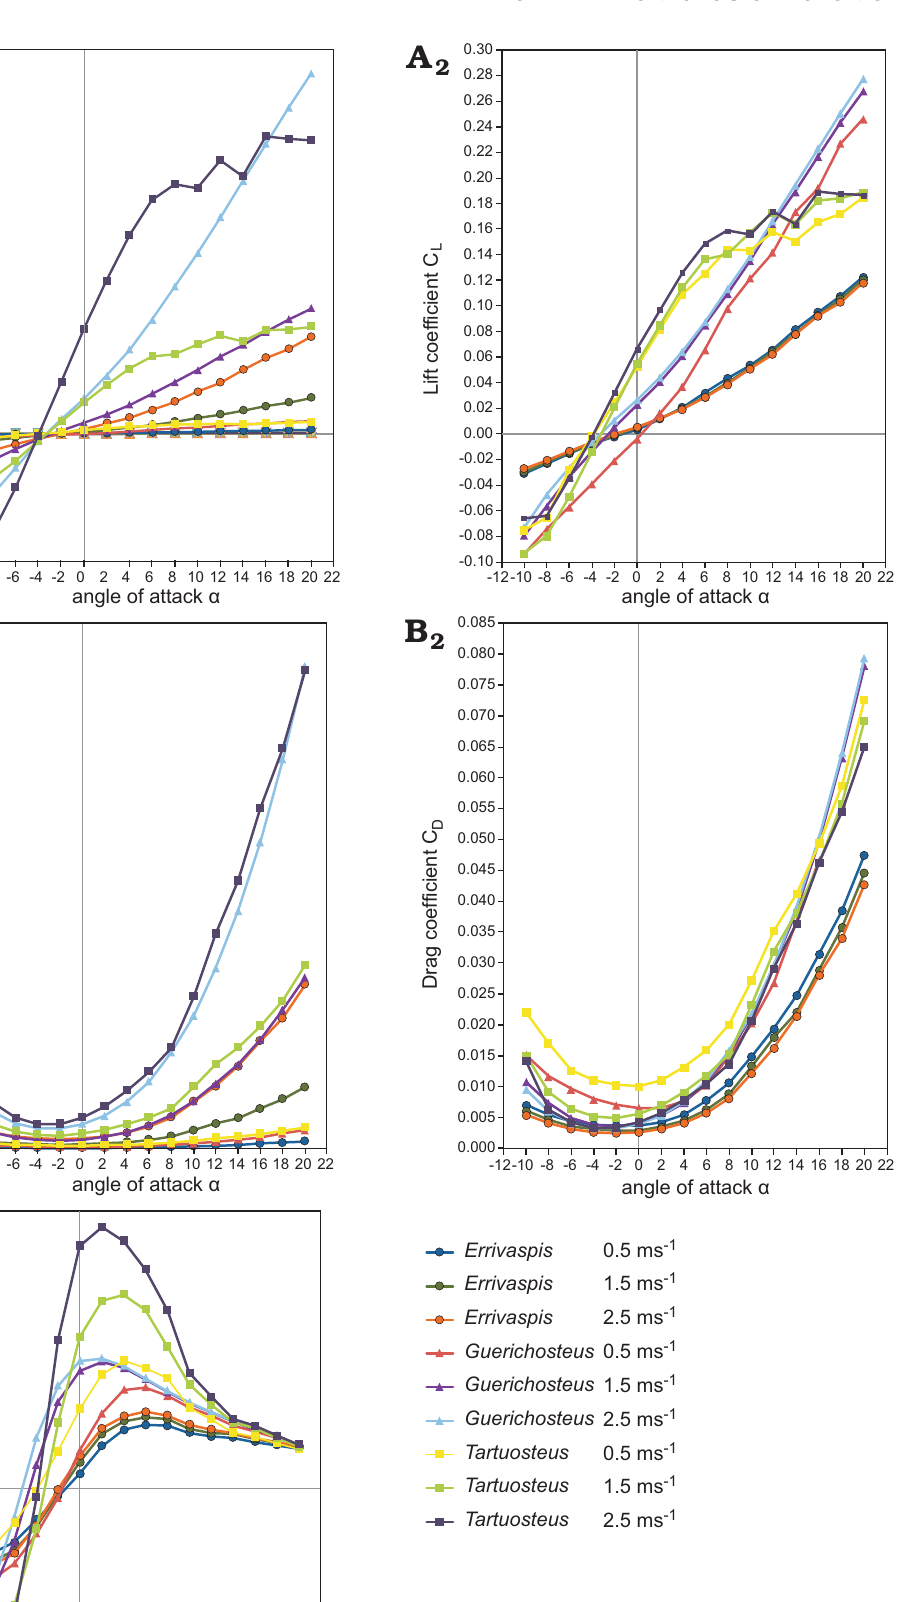
Fig. 3. Comparison lift ( A ), drag ( B ), lift-to-drag ratio ( C ) versus the angle of attack at various velocity for Errivaspis , Guerichosteus , and Tartuosteus